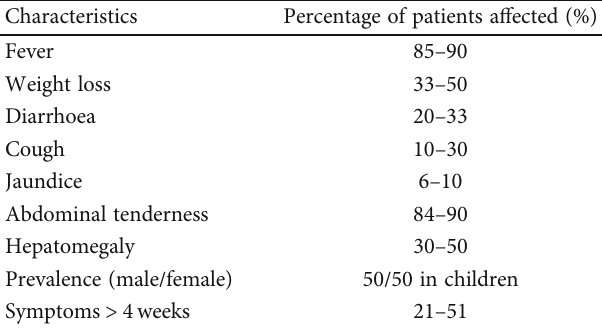
Table 1: Clinical and epidemiological characteristics of amoebic liver